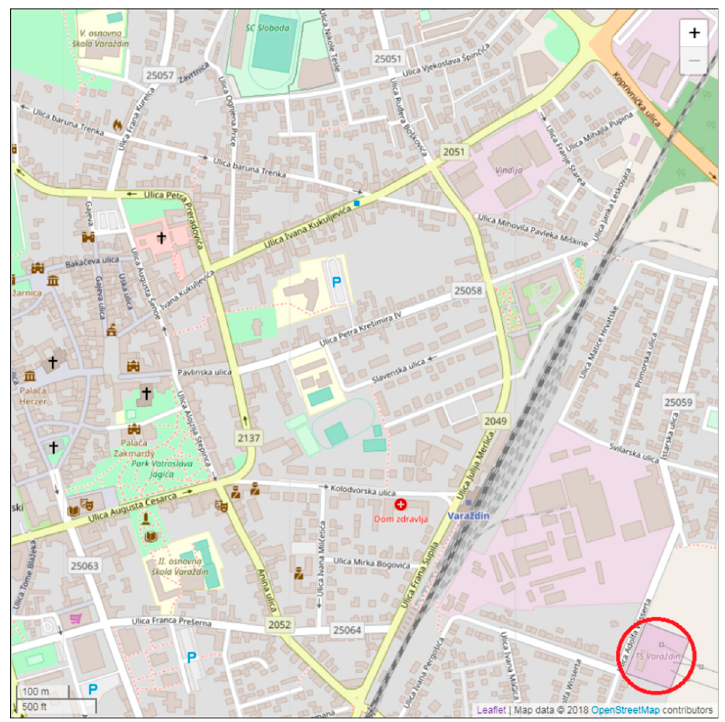
Figure 2 . Varaždin city center Open Street Map image. Figure 2. Varaždin city center Open Street Map